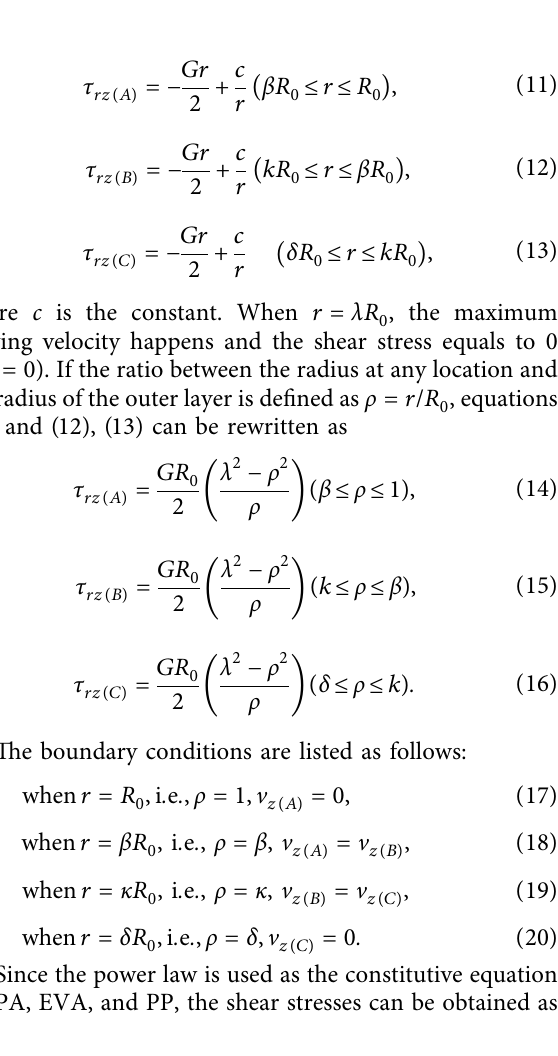
Figure 4: Schematic of the geometry of the three-layered polymer melt coextrusion flow.